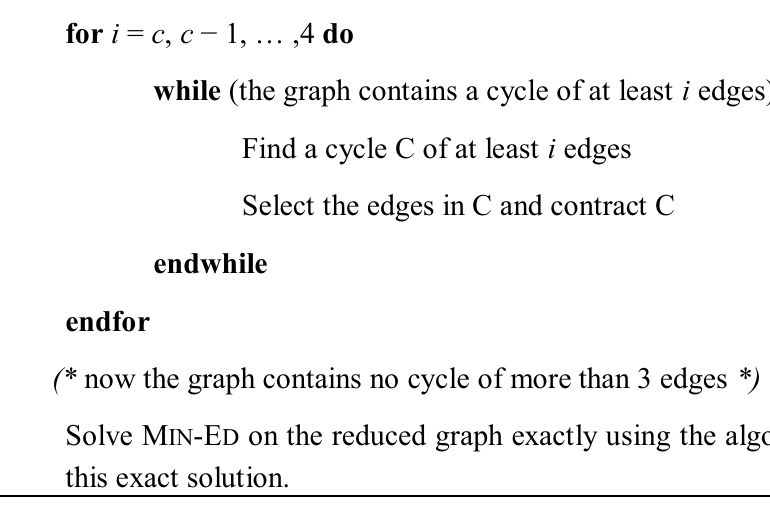
Figure 2. Illustration of a cycle contraction: ( a ) shows the original graph and ( b ) shows